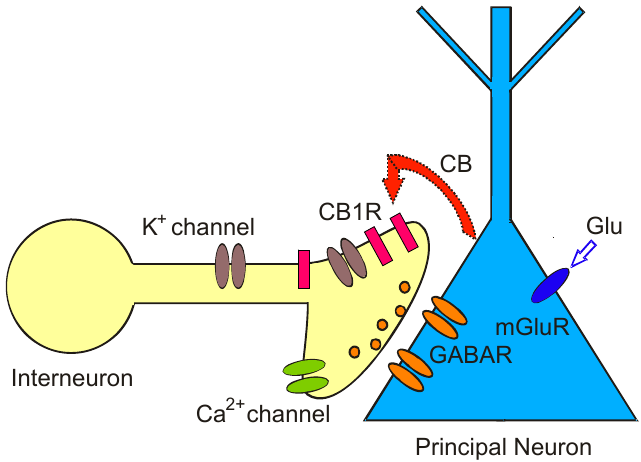
Figure 1. Depolarization-induced Suppression of Inhibition (DSI) is a model for retrograde signaling in the brain and allows assaying real time release of endoCBs from principal neurons as a brief cessation of GABA ouput. Activation of metabotropic glutamate receptors (mGluRs) by glutamate (Glu) on principal neurons or depolarization of postsynaptic principal cells evokes synthesis and release of cannabinoids (CB). Cannabinoids bind to presynaptic cannabinoid receptors (CB1R) on GABAergic interneurons and transiently reduce GABA release from synaptic terminals. As a consequence, GABA A receptor-mediated synaptic currents and GABAergic inhibition are temporarily suppressed in postsynaptic principal